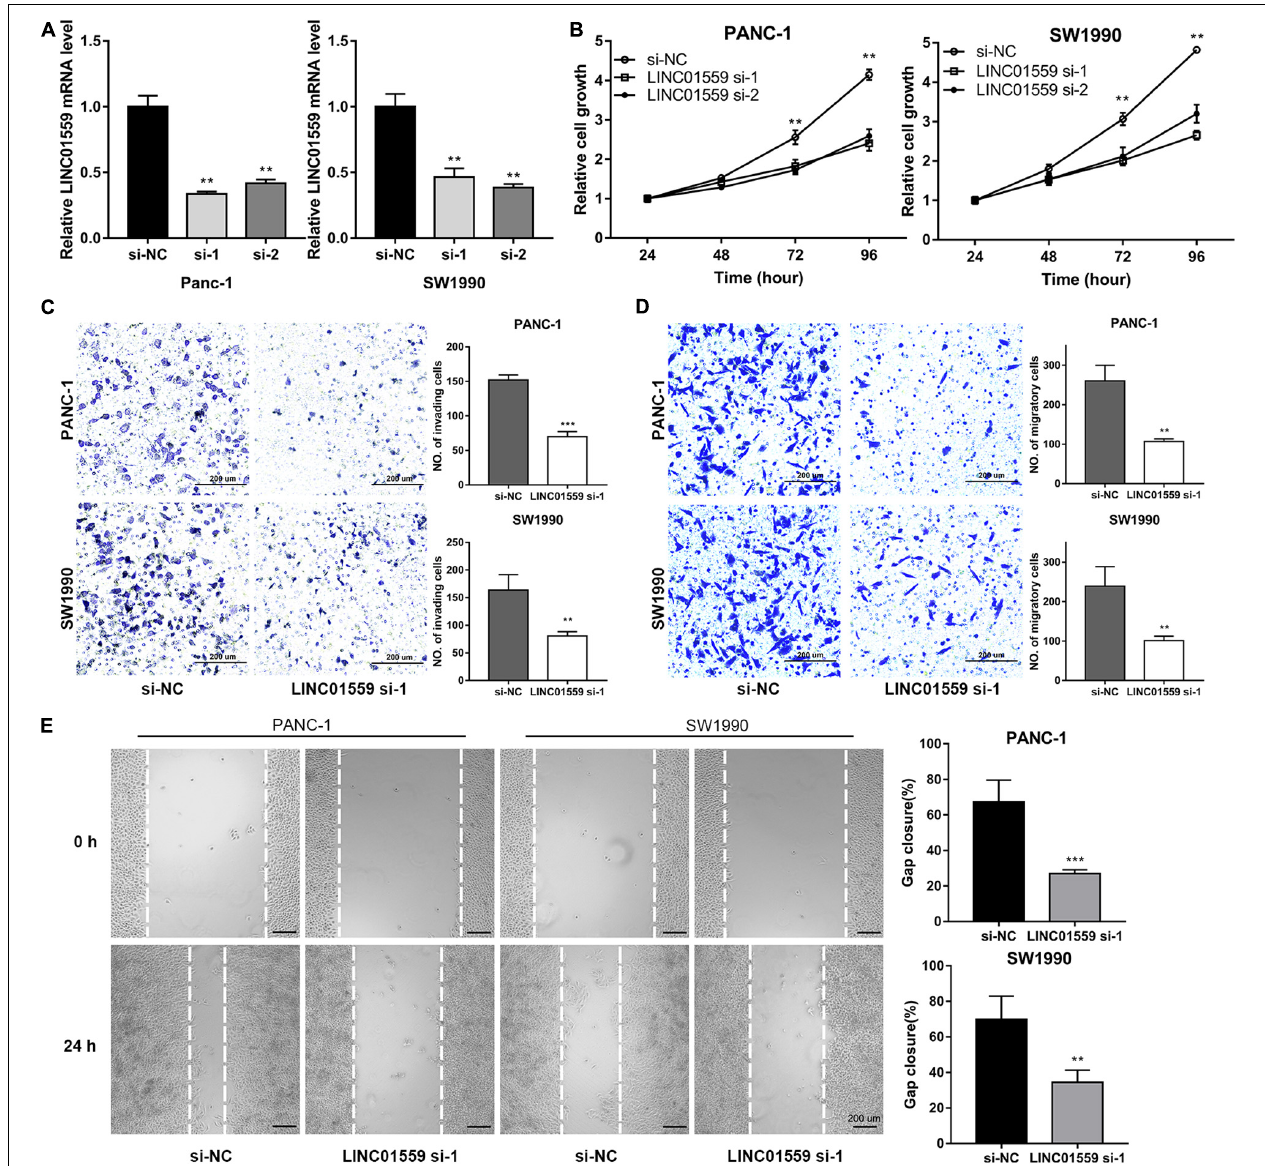
FIGURE 10 | Inhibition of LINC01559 suppresses PC cell proliferation, migration and invasion. (A) qRT-PCR was performed to measure the expression level of LINC01559 in PC cells transfected with si-NC or two siRNA targeting LINC01559. (B) CCK-8 analysis was used to examine the proliferation of PC cells. (C,D) Transwell assays were conducted to evaluate the effect of silencing LINC01559 on PC cell invasion ability (C) and migratory capacity (D) . Scale bar: 200 µ m (200 × ). (E) Wound healing assays showing the capacity of indicated PC cell migration. Scale bar: 200 µ m (40 × ) (** p < 0.01; *** p < 0.001; ns, not